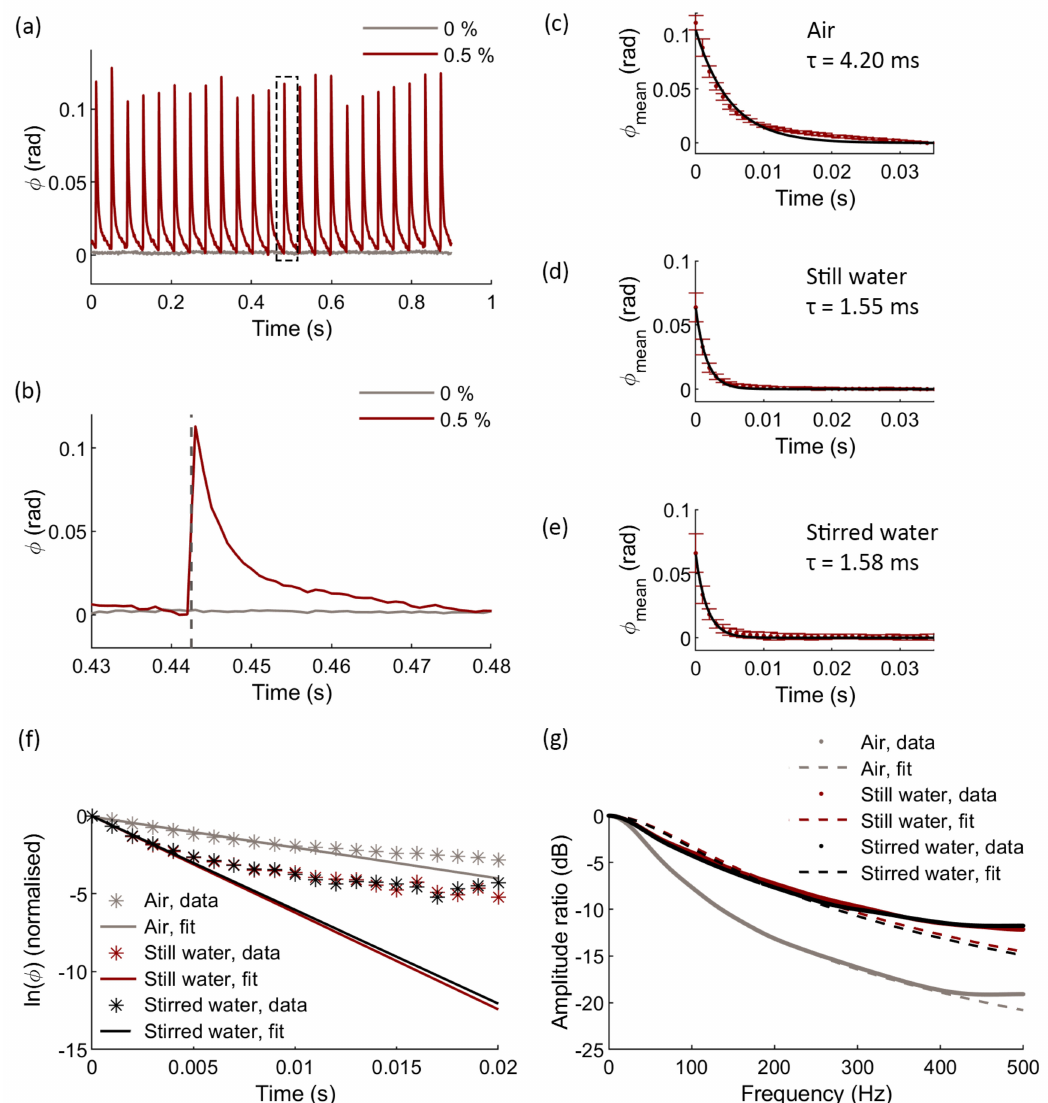
Figure 3. ( a ) Temperature sensor signals during illumination with 10 ns pulses of 532 nm laser light, repeating at 25 Hz; sensors were suspended in air; grey line: polydimethylsiloxane (PDMS) dome with 0% pigment; red line: PDMS dome with 0.5% pigment. ( b ) Enlarged view of one heating pulse; the dotted box in plot ( a ) indicates the region of data shown in plot ( b ). The dashed vertical line in plot ( b ) indicates the assumed time of one of the laser pulses, which occurs between 0.442 and 0.443 s. ( c – e ) Mean impulse response curves ( N = 22 to 24) induced by pulsed laser heating, obtained from the 0.5% pigment-containing dome sensor in different surrounding media: ( c ) air; ( d ) still water; ( e ) stirred water. The solid black lines are fitted curves of the form of Equation (9), from which the time constants τ were obtained. ( f ) Natural logarithm of data and fitted curves shown in in plots ( c – e ) versus time; ( g ) Sensor frequency response in air, still water and stirred water; the amplitude ratio was normalised by dividing by the maximum amplitude ratio occurring at 0 Hz; the dashed lines are √ (cid:0) (cid:1) fitted curves of the form AR norm = 1/ 1 + ω 2 τ 2 , where AR norm is the first-order instrument amplitude ratio given by Equation (10), normalised by dividing by the maximum amplitude ratio at ω = 0